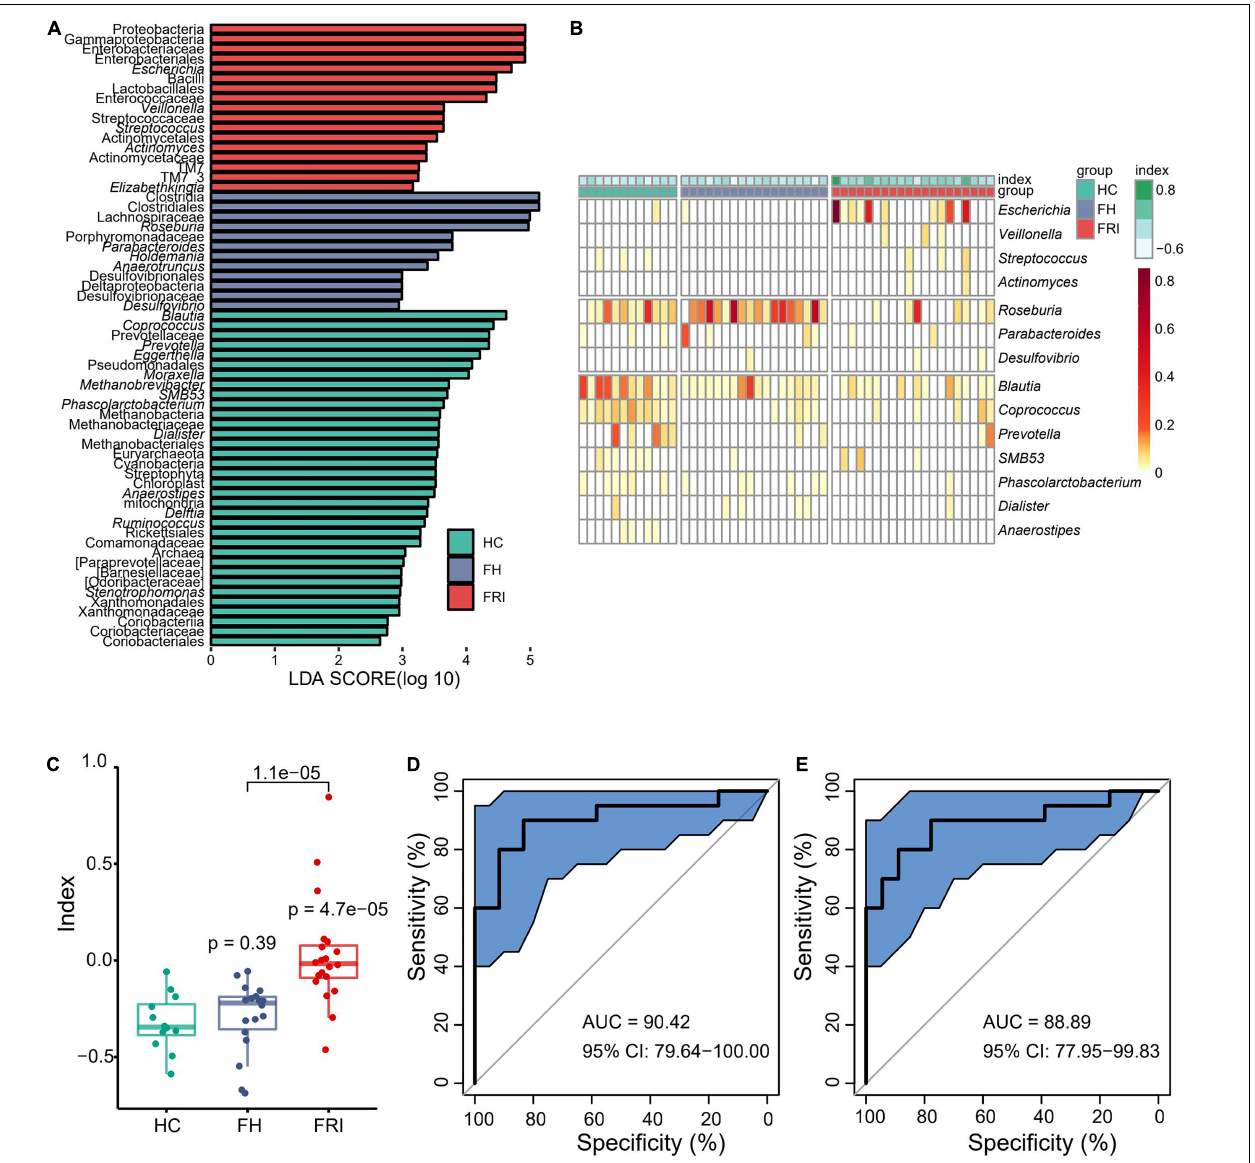
FIGURE 2 | Bacterial differential abundance in FRI, FH, and HC groups. (A) LDA score of Linear discriminant analysis effect size (LEfSe) (FRI vs. FH vs. HC). (B) Bacteria genera for dysbiosis index building. (C) Dysbiosis Index (FRI vs. FH vs. HC). (D) Area under the curve (AUC) showing diagnostic accuracy of gut microbiota composition for FRI vs. HC. (E) AUC showing diagnostic accuracy of gut microbiota composition for FRI vs.